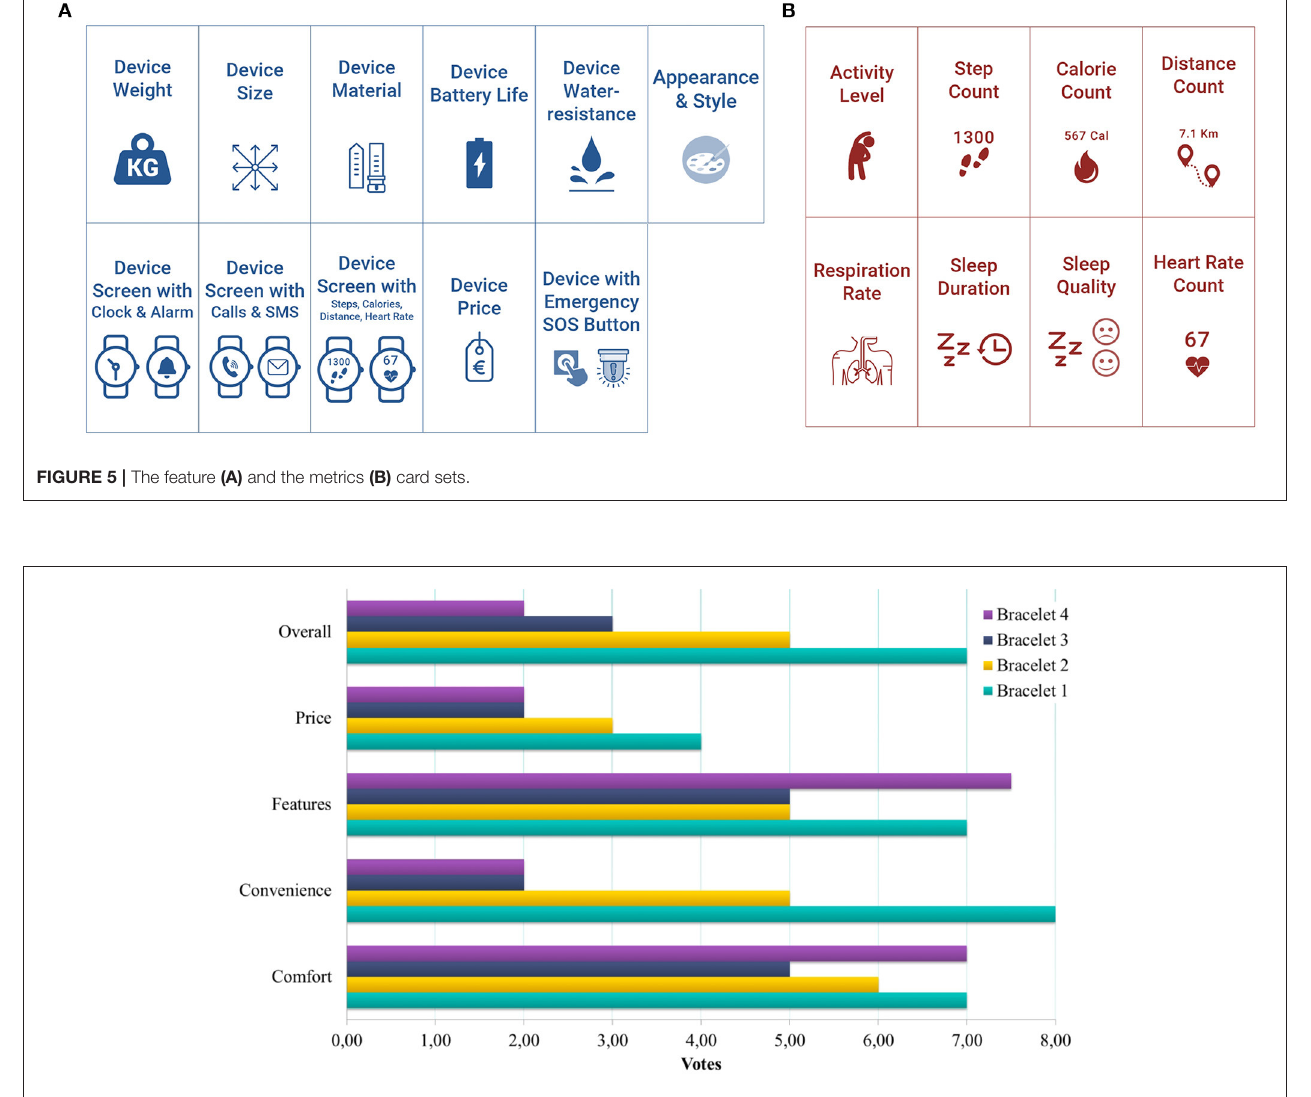
FIGURE 6 | Average rating per device aspect for each of the four bracelets.